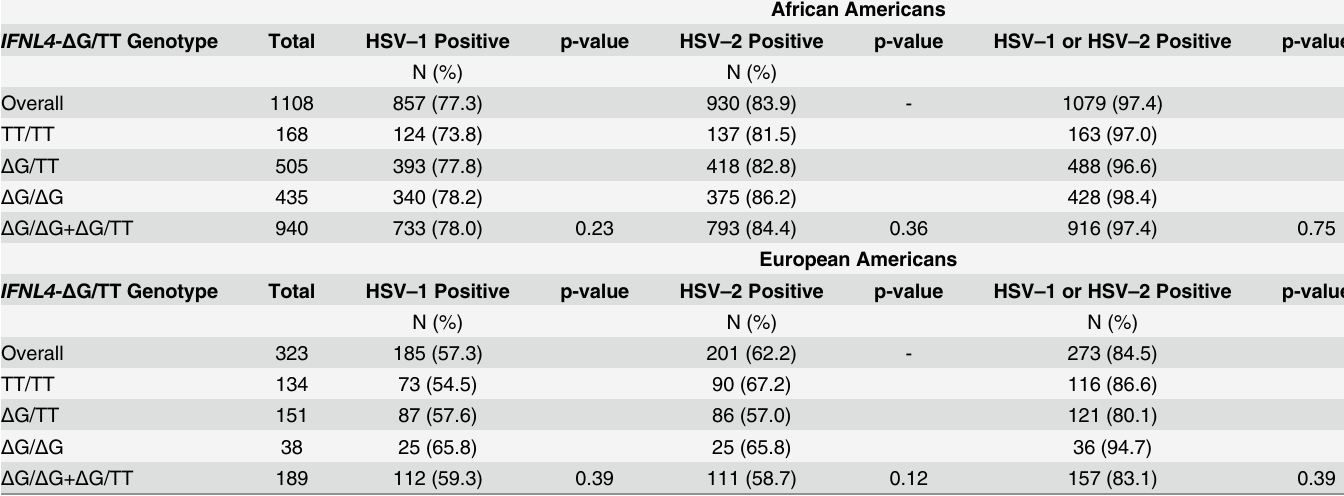
Table 2. Prevalence of antibodies to HSV – 1 and HSV – 2 at enrollment, WIHS 1994 – 95 cohort, by race and IFNL4 genotype (N = 1,431).